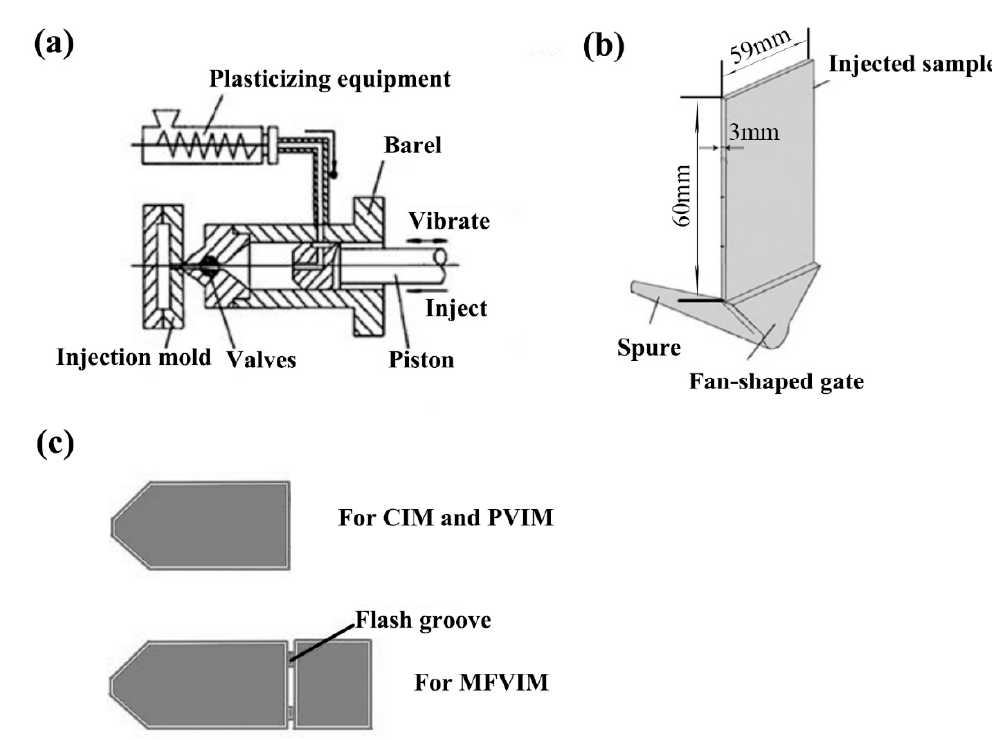
Figure 1. Schematic representation of ( a ) injection-molding machine, ( b ) specimens, and ( c ) mold design for CIM, PVIM, and MFVIM.